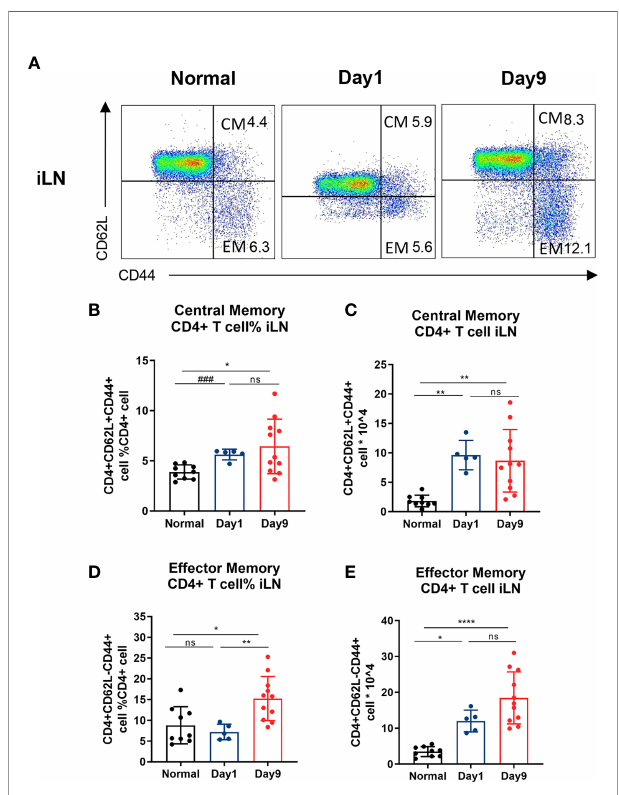
FIGURE 4 | Central/effector memory CD4 + T cells are increased in DTHA mice. Cells were isolated from draining iLN of normal mice and DTHA- induced mice on day 1 and 9 post mBSA challenge and analyzed by fl ow cytometry. (A) Representative fl ow cytometry dot plot of central/effector memory CD4+ T cells from iLN from normal mice and DTHA-induced mice on day 1 and day 9 post mBSA challenge. (B, C) Relative number (B) and absolute number (C) of central memory CD4+ T cells (CD4+CD62L+CD44+) from iLN in given groups. (D, E) Relative number (D) and absolute number (E) of effector memory CD4+ T cells (CD4+CD62L − CD44+) from iLN are shown. Data is presented as mean ± SD. Data of naïve group and day 9 group are from two independent experiments with at least fi ve mice per group per experiment. Data of day 1 group is from one experiment with fi ve mice. Statistical signi fi cance was calculated by ANOVA with Tukey multiple comparison test (*p < 0.05, **p < 0.01, ****p < 0.0001, ns: p > 0.05) or Student ’ s t -test ( ### p<0.001). CM: central memory CD4+ T cell. EM: effector memory CD4+ T